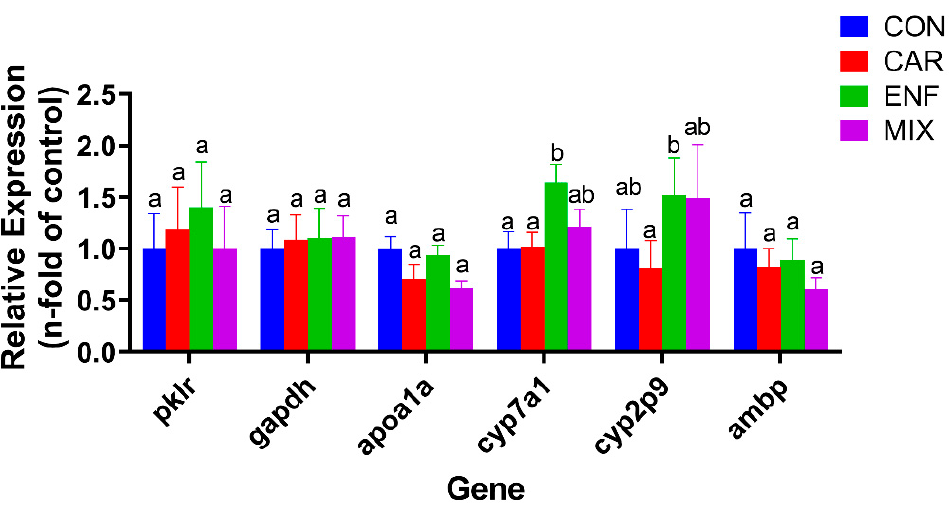
Figure 6. Relative mRNA expression levels of DEGs related to metabolism. Results are expressed as the fold-change relative to the control group. Data are shown as mean ± SEM; (Two-way ANOVA, Tukey’s HSD). Completely different lowercase letters above the bars indicate significant differences ( p < 0.05), while any of the same lowercase letters indicate no significant difference ( p > 0.05).